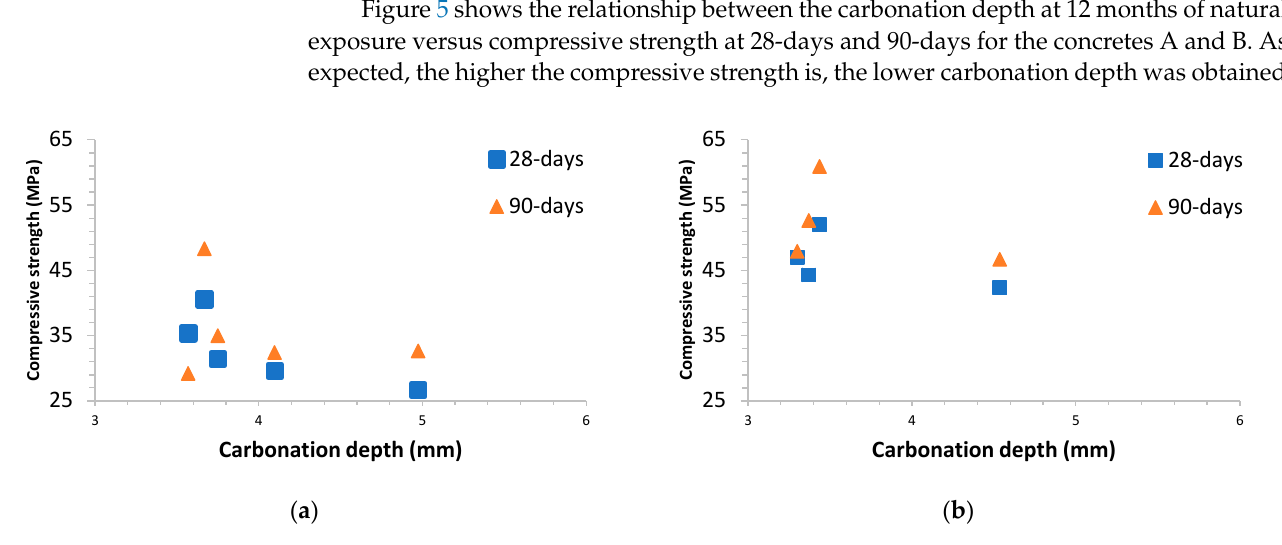
Figure 5. Carbonation depth at 12 months of natural exposure versus compressive strength at 28-days and 90-days: ( a )